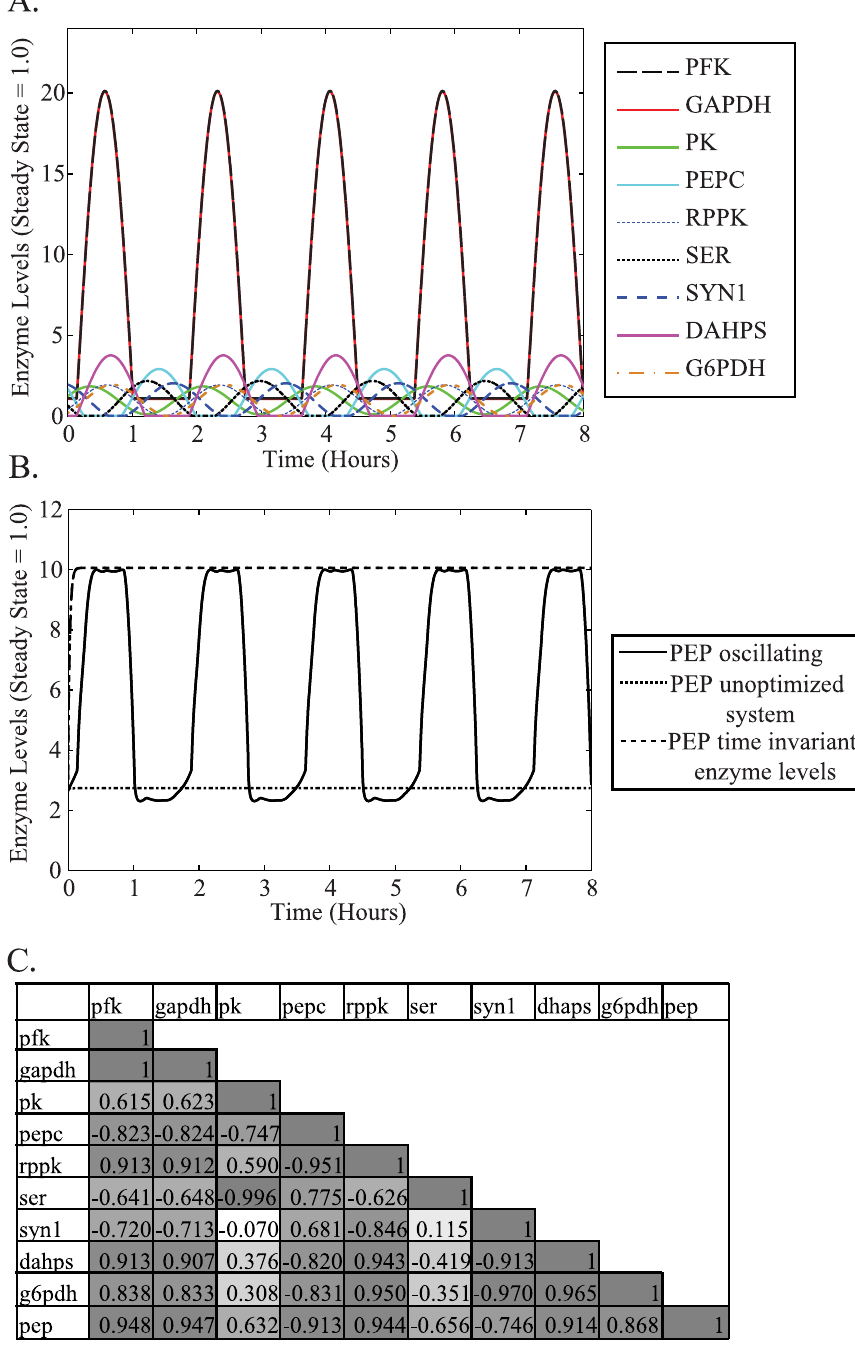
Figure 4. Optimization of PEP-influencing cluster increases intracellular PEP concentration. A . Resulting profiles from an optimization of enzyme levels with an eight hour time horizon. PFK (black dashes) overlaps with GAPDH (red line), and all the other enzymes appear distinctly within the plot. Enzyme levels are measured as deviations from steady state (1.0). B . Oscillations in PEP levels (black line) resulting from oscillations in enzyme levels. The line with smaller dashes represents the PEP levels without inducing oscillations (unoptimized case). The third line with larger dashes indicates the PEP levels when the levels of enzymes are optimized for PEP production without any oscillations (PEP time invariant enzyme levels). PEP levels are in millimolar. C . Correlation coefficients for the oscillating case shown above. The coefficients are colored using a gray scale with the strongest positive (1) and negative ( 2 1) correlations being darkest and weakest correlations colored lightest. metabolic optimization problem. The method outlined here is Oscillating enzyme levels inside cells requires (1) a method to generally applicable to any organism that is genetically pliable and induce periodic changes in vivo and (2) the ability to create and for which a kinetic model can be constructed. manipulate regulatory clusters. Since the creation of the Goodwin